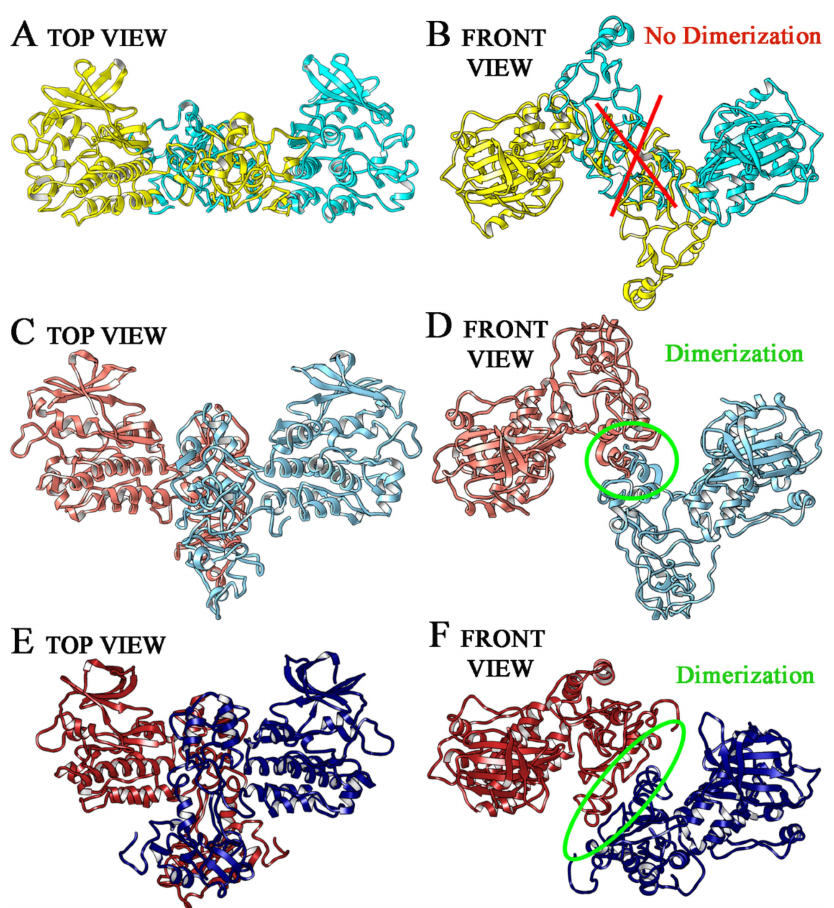
Figure 4. EGFR cytoplasmic domains in dimerization form. We reported in yellow and light green the domains of wild type EGFR ( A top view , B front view ), in orange and light blue the T790M / L858R EGFR ( C top view , D front view ) and in red and blue the ELREA deletion EGFR ( E top view , F front view ). To confirm that the D-domain orientation can lead to the constitutive activation of T790M / L858R EGFR, or any of the other EGFR forms, a comparison of our models with the activated